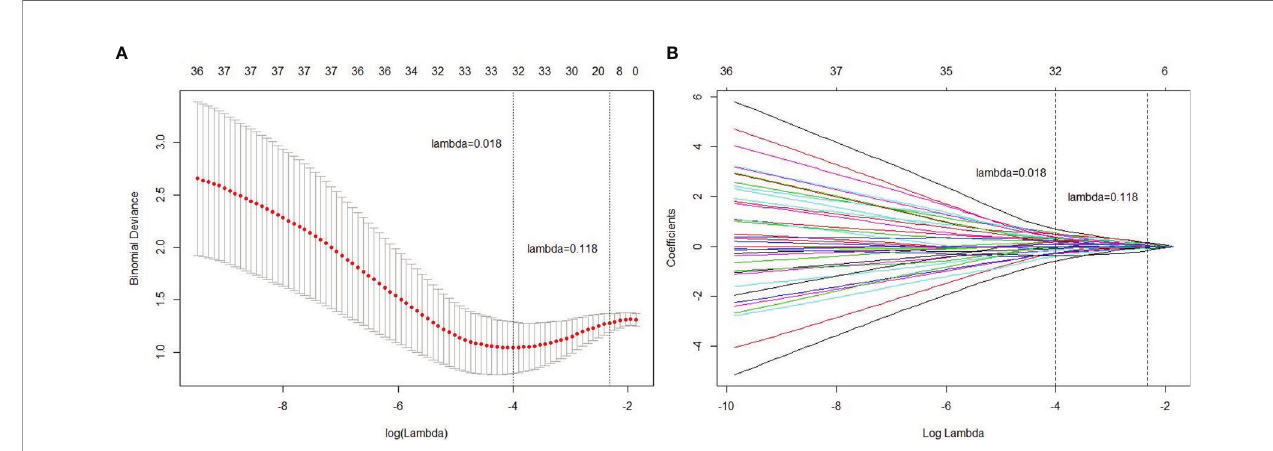
FIGURE 3 | Radiomics feature selection using the least absolute shrinkage and selection operator (LASSO) regression model. (A) Tuning parameter (lambda) selection in the LASSO model used 4-fold cross-validation via minimum criteria. (B) A coef fi cient pro fi le plot was produced against the log (lambda) sequence. Vertical line was drawn at the value selected using 4-fold cross-validation, where optimal lambda resulted in 8 non-zero coef fi cients